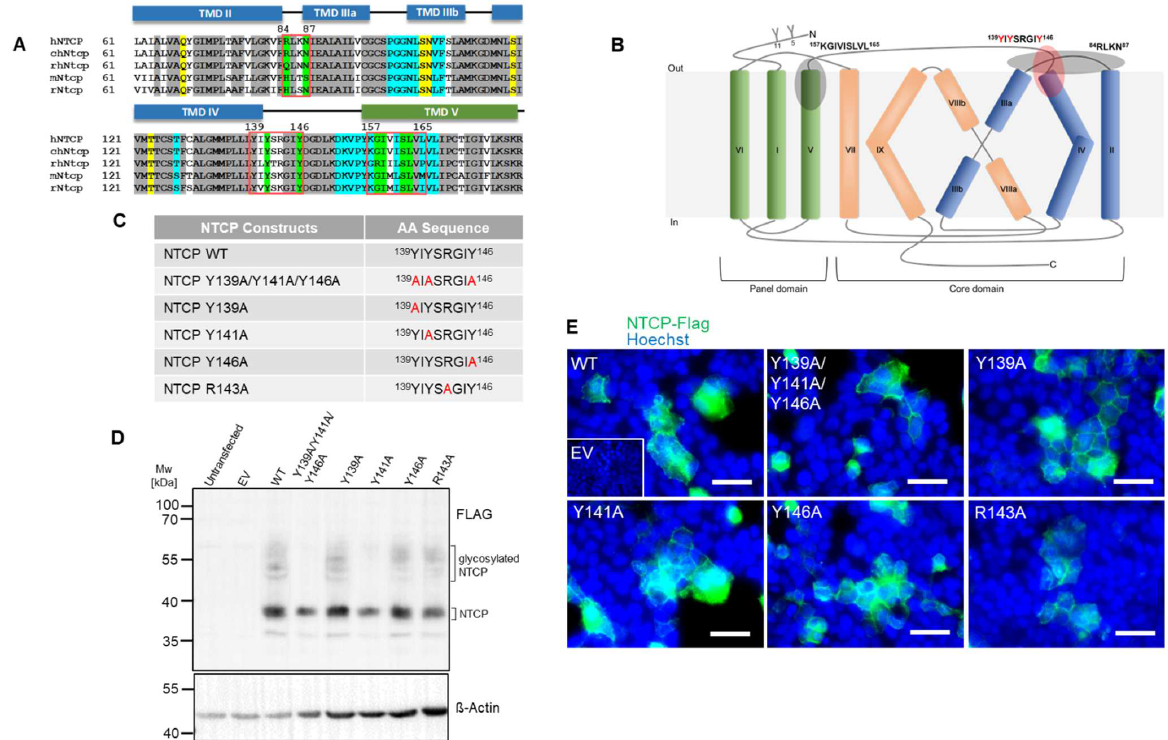
Figure 1. Identification of the tyrosine-enriched motif 139YIYSRGIY146 within human NTCP and characterization of tyrosine-to-alanine NTCP mutants. ( A ) Multiple sequence alignment of human NTCP (hNTCP; Uniprot: Q14973), chimpanzee Ntcp (chNtcp; Uniprot: H2Q8J0), rhesus monkey Ntcp (rhNtcp; Uniprot: F6YRK3), mouse Ntcp (mNtcp; Uniprot: O08705) and rat Ntcp (rNtcp, Uniprot: P26435) using EBI ClustalW algorithm. NTCP sequences that belong to TMD II-IV (blue boxes), TMD V (green box) and loops (black lines) are indicated. Grey shading points out evolutionarily conserved amino acid residues. Red boxes indicate important contact sites at NTCP for the viral preS1 peptide, including the 139YIYSRGIY146 motif analyzed in the present study. Putative residues interacting with the co-substrate Na + are highlighted in yellow. Residues forming the proposed substrate binding pore are highlighted in light blue. Key residues important for preS1 peptide binding (according to [3,11,13–15]) are highlighted in green. ( B ) Membrane topology of human NTCP with nine transmembrane domains based on the recent cryo-EM structures of human NTCP (PDB: 7PQG, 7PQQ, 7VAD, 7VAG, 7WSI, and 7FCI). Transmembrane domains are labeled with Roman numbers and NTCP sequences are colored according to ( A ): TMDs I, V, and VI green; II, III, and IV blue; VII, VIII, and IX orange. The positions of the proposed preS1 binding motifs 84RLKN87, 157KGIVISLVL165, and 139YIYSRGIY146 are highlighted. “Y” indicates N-glycosylation at the positions N5 and N11 of NTCP. The proposed panel and core domains are indicated. ( C ) List of generated NTCP mutants with the substituted amino acid residues marked in red. ( D ) Protein expression of the NTCP mutant proteins in HEK293 cells as demonstrated by Western blotting using anti-FLAG antibody. Expression of beta-actin served as loading control. MW, molecular weight; EV, empty vector. ( E ) Microscopy pictures of HEK293 cells transiently transfected with NTCP wt and mutant constructs. NTCP expression was detected using primary anti-FLAG and Alexa Fluor 488-labeled goat anti-rabbit secondary antibodies (green). Nuclei were stained by Hoechst 33342 (blue). Scale bars: 40 µ m. All data are representative of three independent